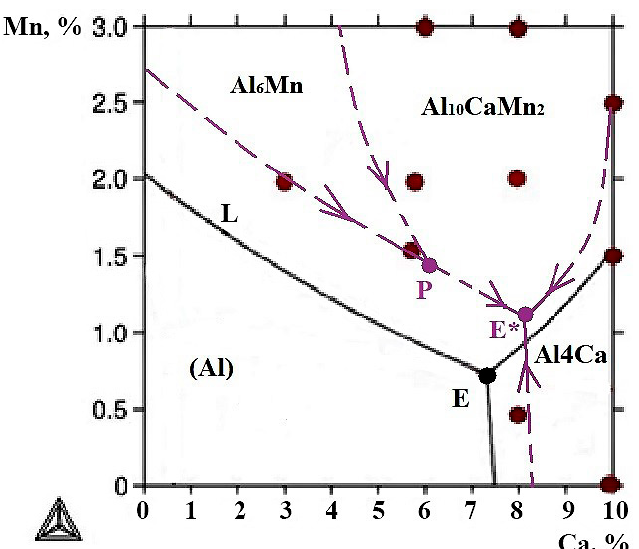
Figure 2. The predicted view of the Al-Ca-Mn phase diagram in the Al-rich region (solid line— calculation, dotted line—experiment).